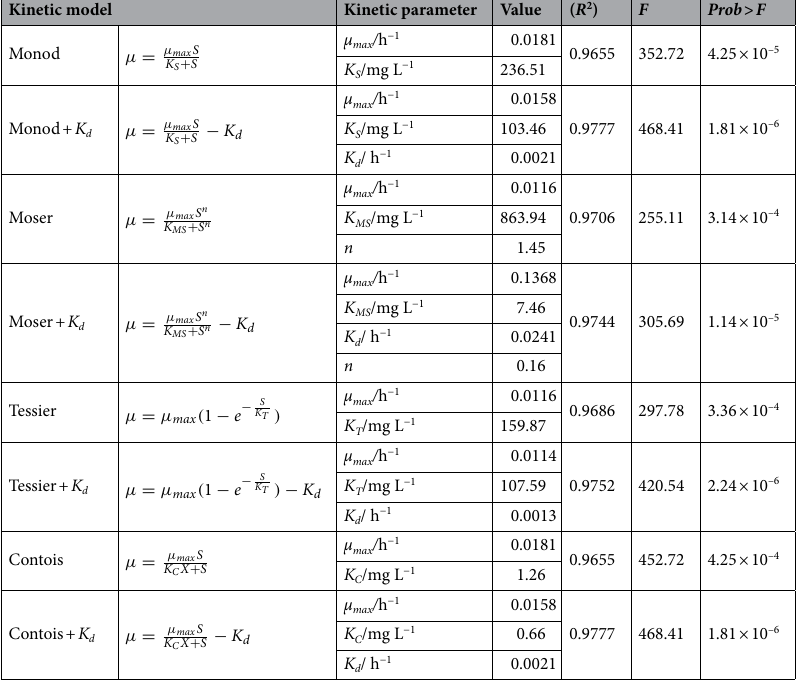
Table 2. Kinetic parameters and statistic results from the nonlinear regression analysis of μ versus